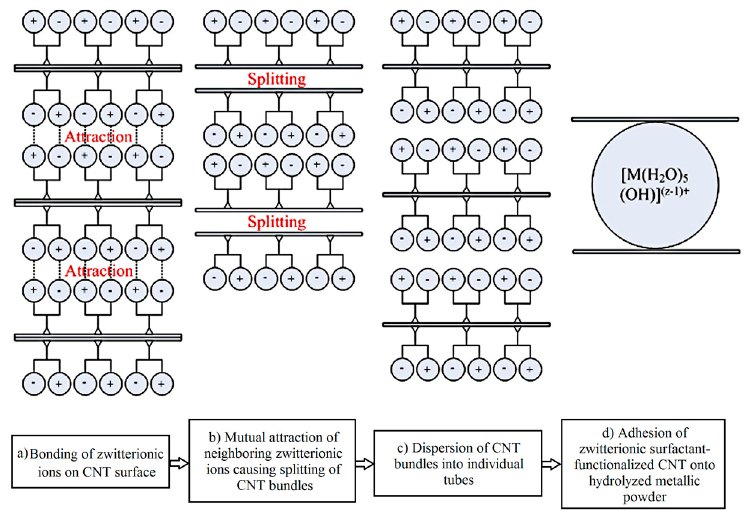
Figure 6. A schematic illustration of the mechanism by which zwitterionic surfactants disassemble CNT bundles [47]. (Reproduced with permission from [47], Elsevier, 2014.)